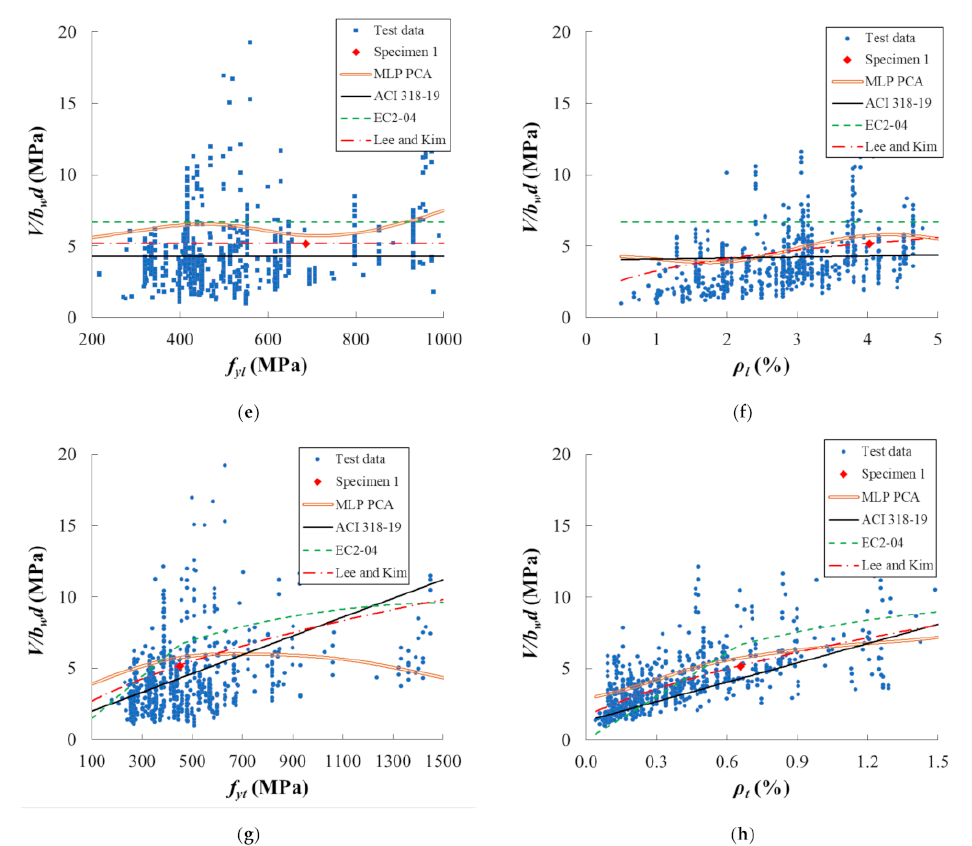
Figure 5. Parametric study. A total of eight variables were varied one at a time while the other variables were fixed. ( a ) Beam width; ( b ) effective depth; ( c ) shear span; ( d ) concrete strength; ( e ) lon- gitudinal reinforcement strength; ( f ) longitudinal reinforcement ratio; ( g ) transverse reinforcement yield strength; ( h ) transverse reinforcement